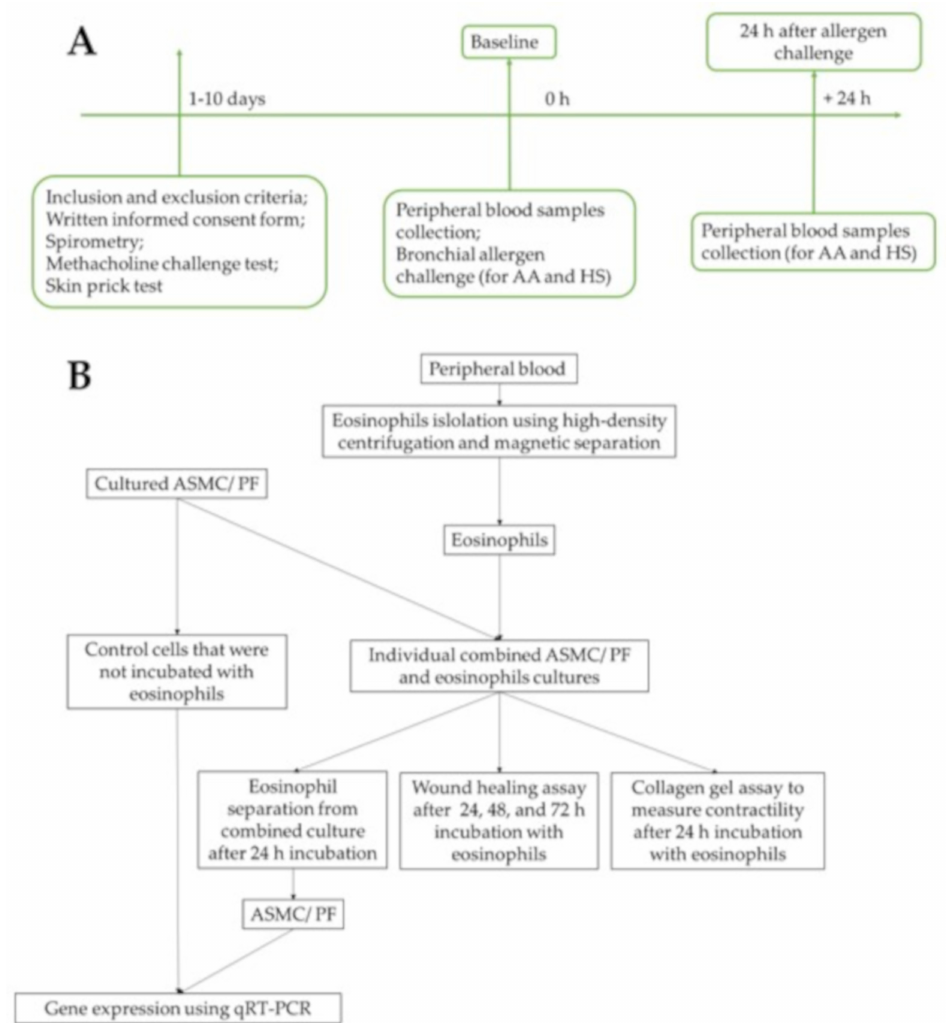
Figure 1. Flowchart of the study design. ( A )—Recruitment of study subjects, clinical examination of allergic asthma patients and healthy subjects. ( B )—Experimental workflow. AA—allergic asthma; ASMC—airway smooth muscle cells; HS—healthy subjects; PF—pulmonary fibroblasts; qRT-PCR—quantitative reverse transcription polymerase chain